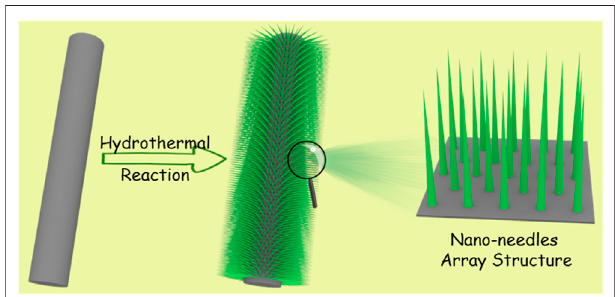
Frontiers in Chemistry |